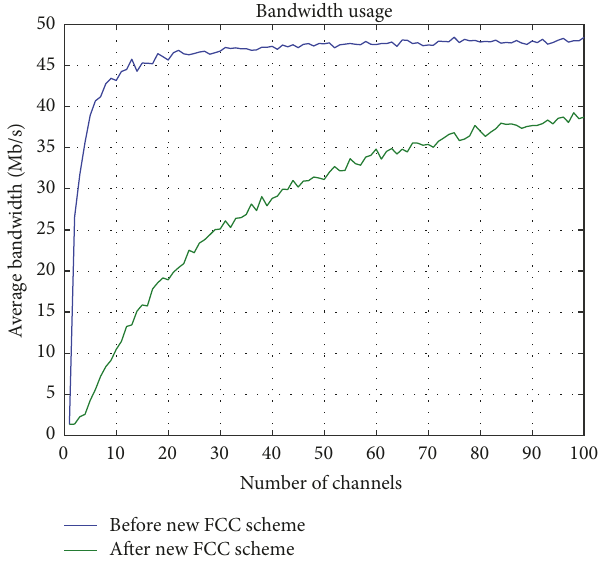
Figure 14: Bandwidth behavior in terms of watching